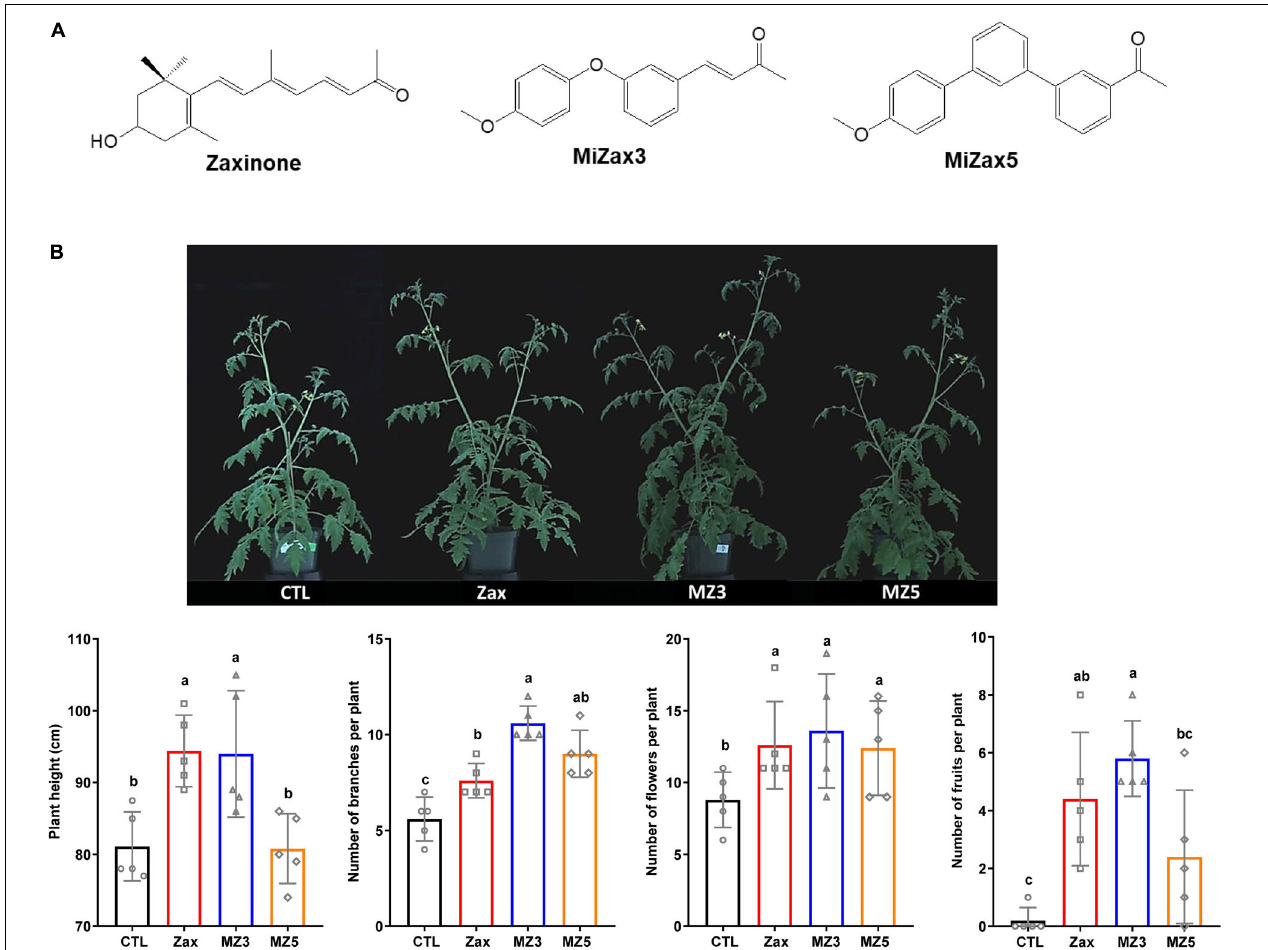
FIGURE 1 | (A) Chemical structures of zaxinone, MiZax3, and MiZax5. (B) Foliar application of Zax, MZ3, and MZ5 at 5 µ M on tomato plants under greenhouse conditions in 2019. Each data point represents one plant ( n = 5). Data represent mean ± SD. Statistical analysis was performed using one-way ANOVA and